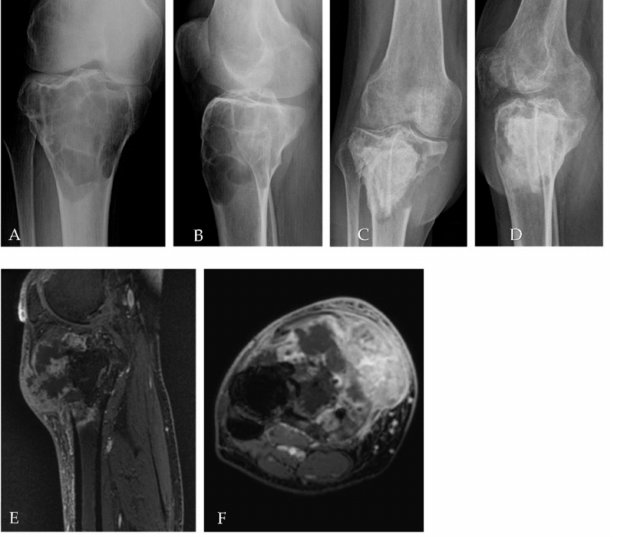
Figure 5. ( A , B ) The RXs of the right knee performed at time of initial diagnosis, showed a large, well- defined osteolytic lesion involving the tibial plateau and the proximal third of the tibial shaft, with thinning of the cortical bone. The RX ( C , D ) of the right leg performed after neoadjuvant treatment with denosumab showed the presence of a lytic alteration of the proximal meta-epiphyseal region with interruption of the cortical bone on the medial aspect of the right tibia; an MRI ( E , F ) confirmed the present of solid inhomogeneous tissue in the meta-epiphyseal of the tibia with significant involvement of extraskeletal soft tissue.